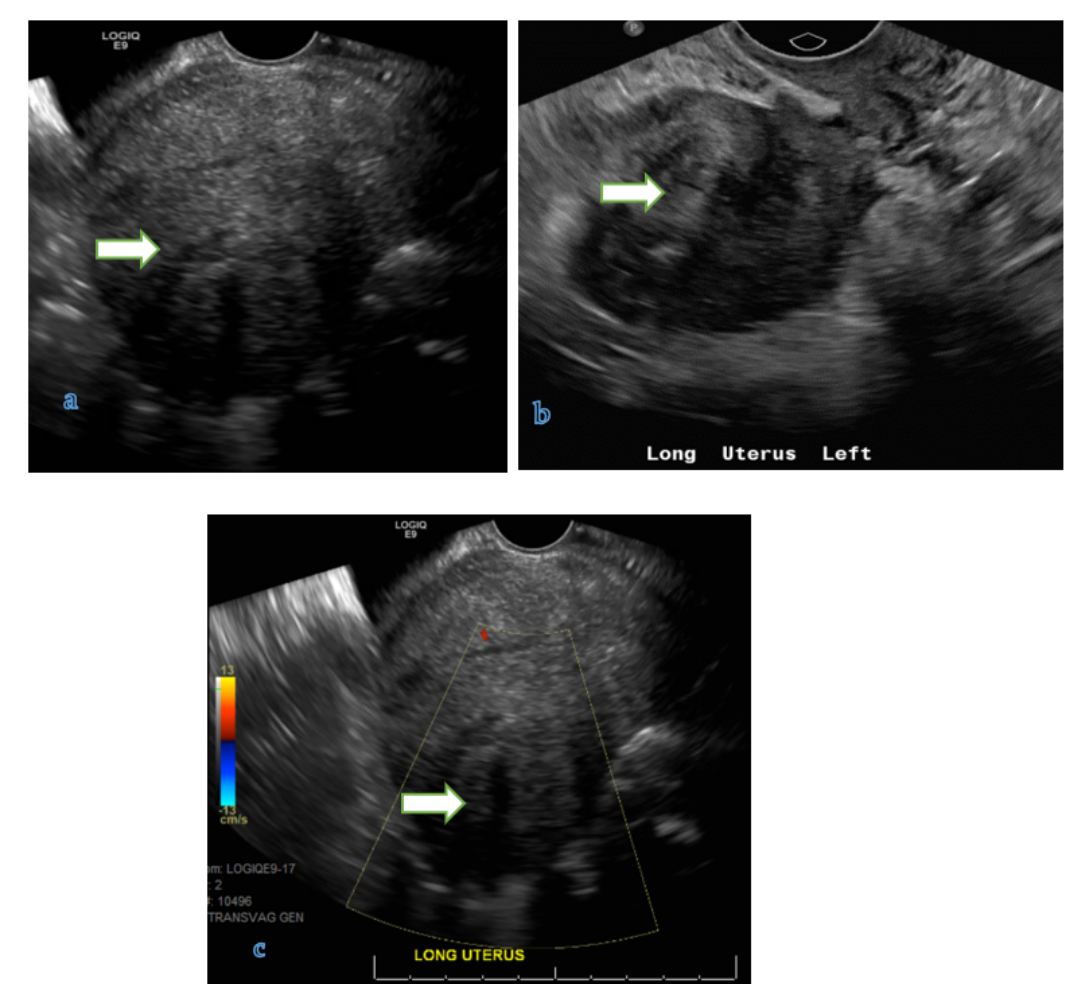
Figure 1. Transvaginal gray scale ( a , b ) and color Doppler ( c ) ultrasound images of the pelvis in a 41 year old lady with history of dysfunctional uterine bleeding show a 5.2 × 4.2 × 3.5 cm uterine mass with posterior shadowing without hypervascularity on color Doppler (B) consistent with a uterine fibroid.